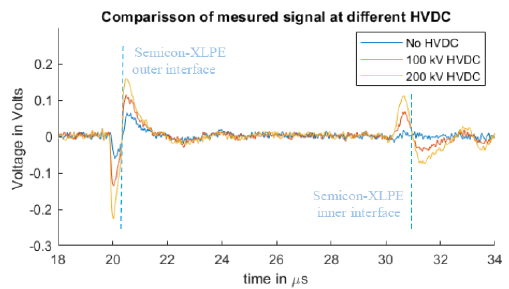
Figure 5. Measured signals with different applied HVDC magnitudes and a 5.5 kV pulsed voltage.